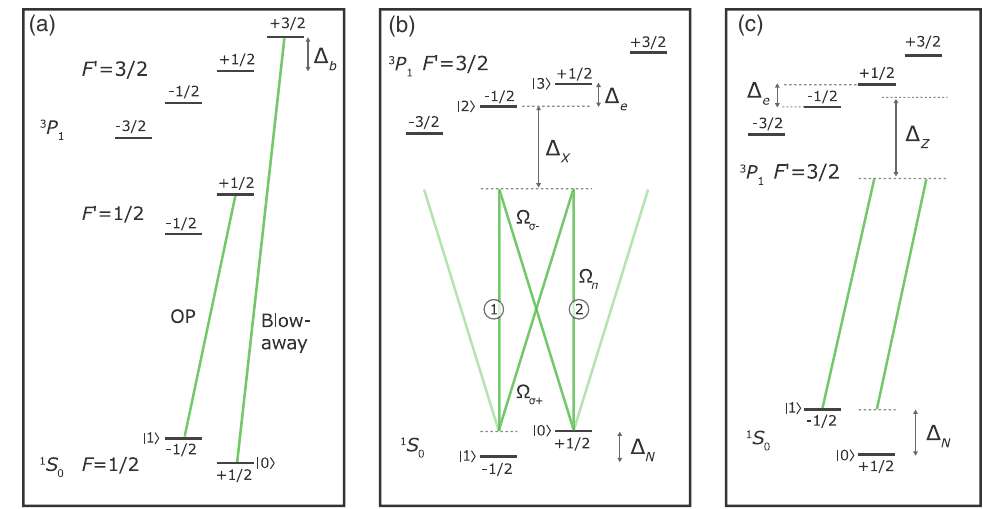
FIG. 10. Nuclear-spin preparation, manipulation, and detection. (a) We prepare the spin state in j 0 i by optical pumping (OP) through 3 P 1 = 2 ; m 1 = 2 i and detect the state destructively by driving the cycling transition j 0 i ↔ j F 0 ¼ 3 = 2 ; m 3 = 2 i until 1 j F 0 ¼ F 0 ¼ þ F 0 ¼ þ 1 = 2 i and j F 0 ¼ 3 = 2 ; m 3 = 2 i states by atoms in the j 0 i state are expelled from their tweezers. We split the j F 0 ¼ 3 = 2 ; m F 0 ¼ þ F 0 ¼ þ Δ 1 = 2 i level by the = ð 2 π Þ ¼ 35 MHz during blow-away detection to minimize off-resonant pumping through the j F 0 ¼ 3 = 2 ; m b F 0 ¼ þ blow-away beam. (b) X rotations in the high-Rabi regime. The two Raman pathways couple the states j 0 i and j 1 i through two different excited states j 2 i and j 3 i . The splitting between the nuclear-spin states is Δ , determined by both the external magnetic field and light N = ð 2 π Þ ≃ − 180 MHz, much larger than the Δ = ð 2 π Þ ¼ 2 . 65 MHz shifts from the drive beam. The detuning from the excited states is Δ X e 1 = 2 i levels. The Rabi coupling in the different arms is set by the dipole coupling matrix splitting between the j F 0 ¼ 3 = 2 ; m F 0 ¼ (cid:3) elements and the polarization angle of the drive beam. (c) Level diagram showing the σ þ -polarized Z beam coupling to the j F 0 ¼ 3 = 2 ; m F 0 ¼ þ 1 = 2 i and j F 0 ¼ 3 = 2 ; m F 0 ¼ þ 3 = 2 i states. In the case of Δ Z ≫ Δ e , the larger coupling matrix element on the 3 = 2 i gives a larger light shift on the j 0 i spin level. This splits the nuclear-spin states and stretched transition to j F 0 ¼ 3 = 2 ; m F 0 ¼ þ allows us to perform fast rotations about the Z